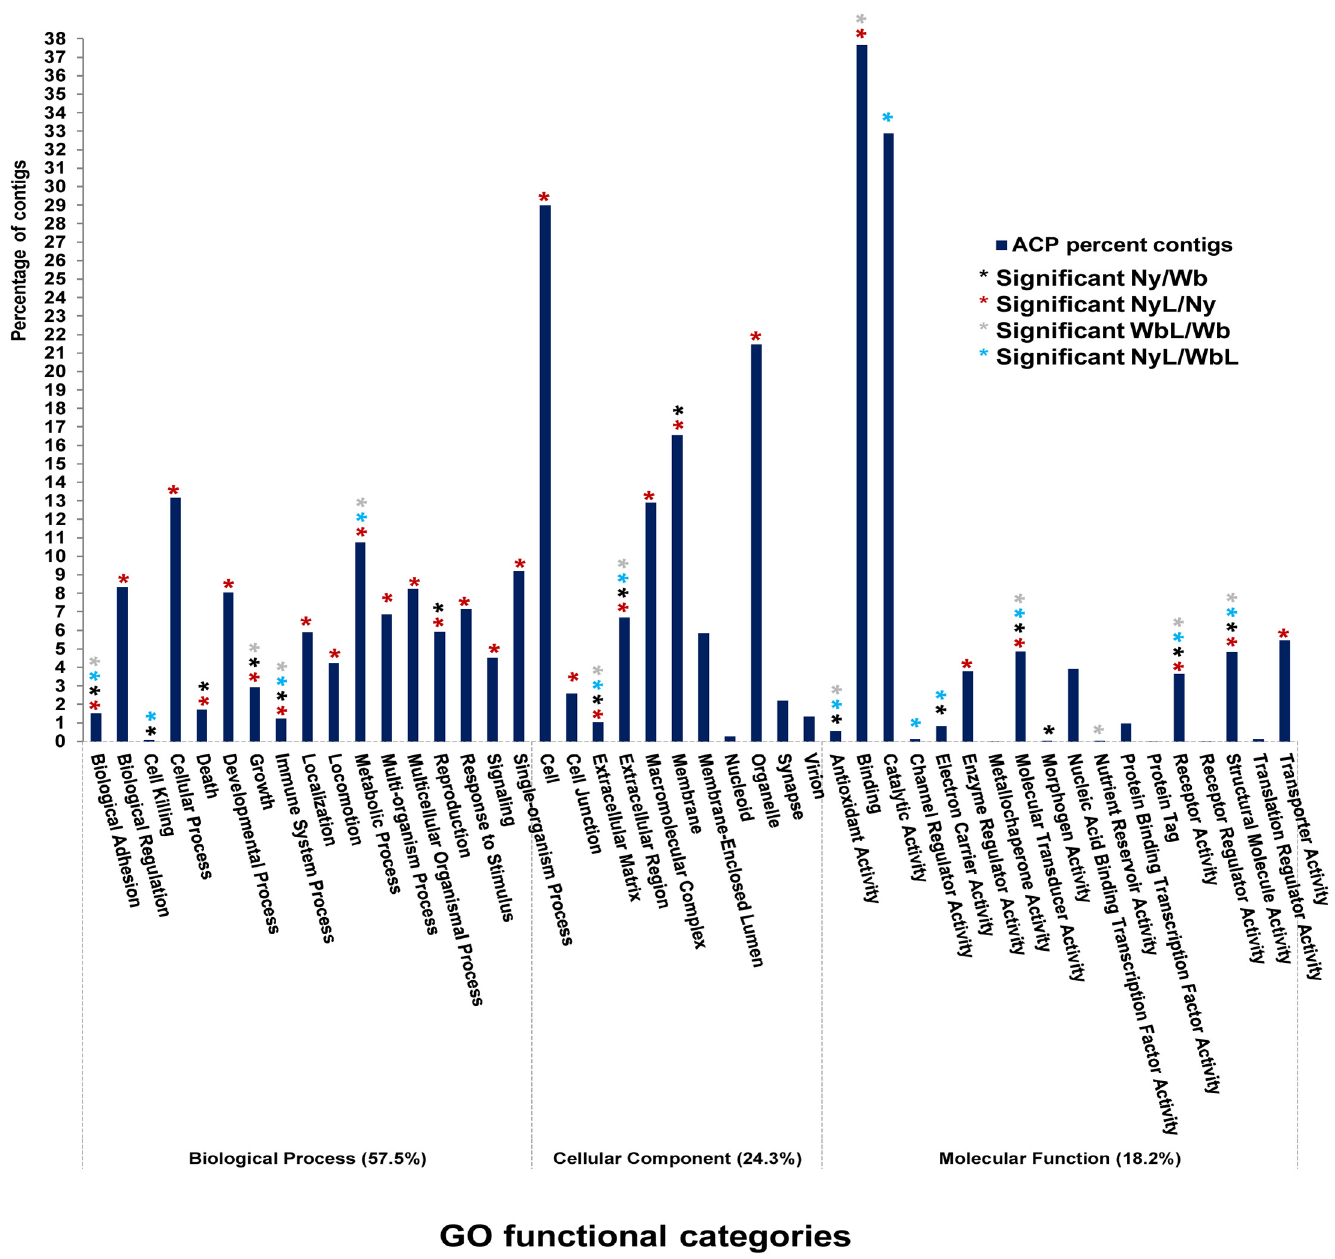
Fig 4. The Gene Ontology classification of annotated, differentially expressed Asian citrus psyllid (ACP) contigs, with altered expression in the presence or absence of Ca . Liberibacter asiaticus (CLas). The y-axis (blue bar) shows the percentage distribution of the contigs in each functional category, and the x-axis shows the 46 functional categories to which ACP contigs were assigned. Categories that contain a significant number of differentially expressed contigs are represented by an asterisk * above the blue bar, for each pairwise comparison: ACP nymphs x adults (Ny/Wb-black asterisk), infected x uninfected nymphs (NyL/Ny- blue asterisk), infected x uninfected adults (WbL/Wb — red asterisk), and infected nymphs x adults (NyL/WbL — grey asterisk). The GO classifications for contigs that showed significantly different expression levels were identified using p -value cut off 0.05, which was based on edgeR statistics from which selected genes have been considered as prospective candidate effectors relevant to the ACP-CLas circulative, propagative transmission pathway.